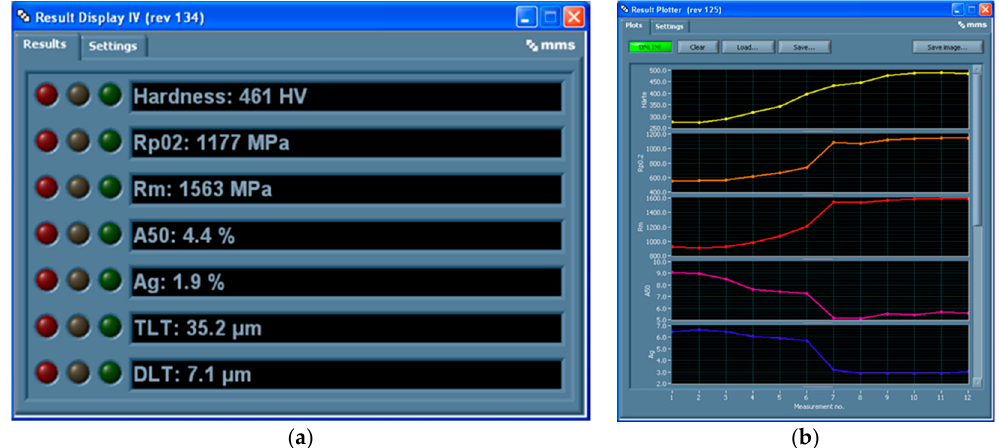
Figure 22. Results of the application of a calibrated 3MA system: ( a ) screenshot of the results displayed after a single 3MA measurement and ( b ) profiles of mechanical properties in a sharp transition zone.